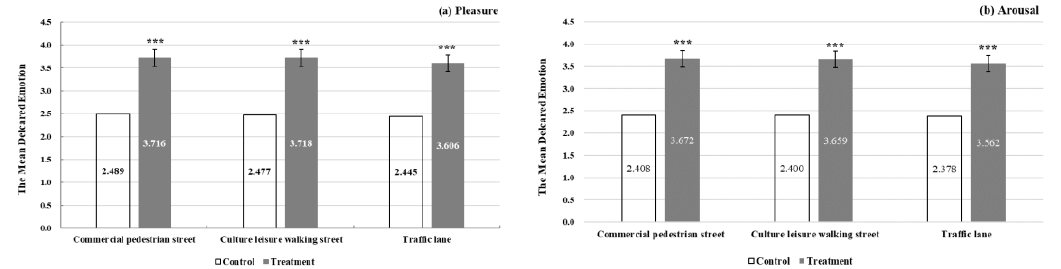
Figure A1. The impact of the three scales of intervention on tourists ’ momentary emotional experi- ence; ( a ) pleasure, ( b ) arousal. Note: Error bars represent 95% confidence interval. *** p  0.001.